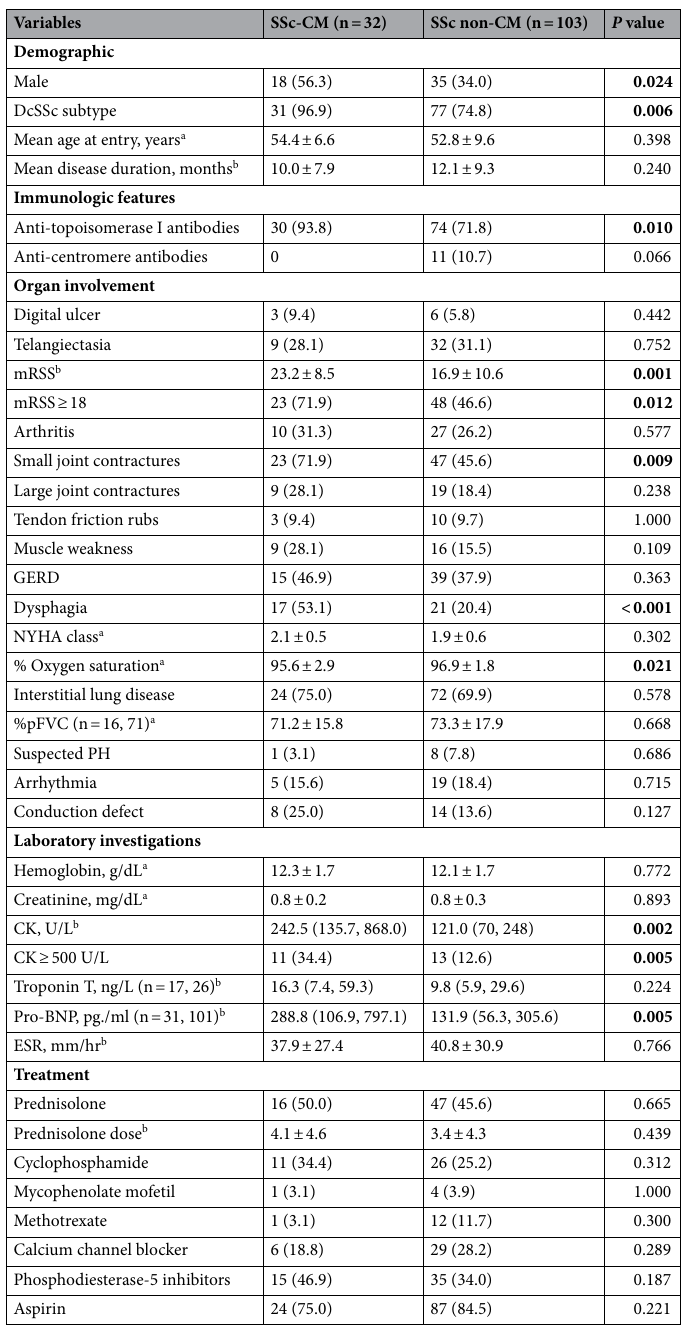
Table 1. Demographic and clinical manifestations between early SSc-CM and non-CM at study entry. Values are expressed as mean ± SD, median (IQR 1,3), or n (%). mRSS modified Rodnan skin score,